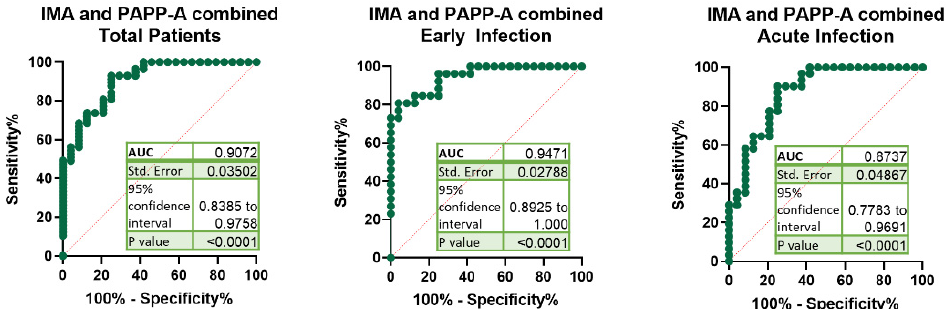
Figure 4. Receiver operating characteristic (ROC) of the IMA and PAPP-A combination. ROC curves and area under the curve (AUC) comparing the potential of the combination of ischemia-modified albumin (IMA) and pregnancy-associated plasma protein-A (PAPP-A) to diagnose COVID-19 (total, early infection and acute infection).